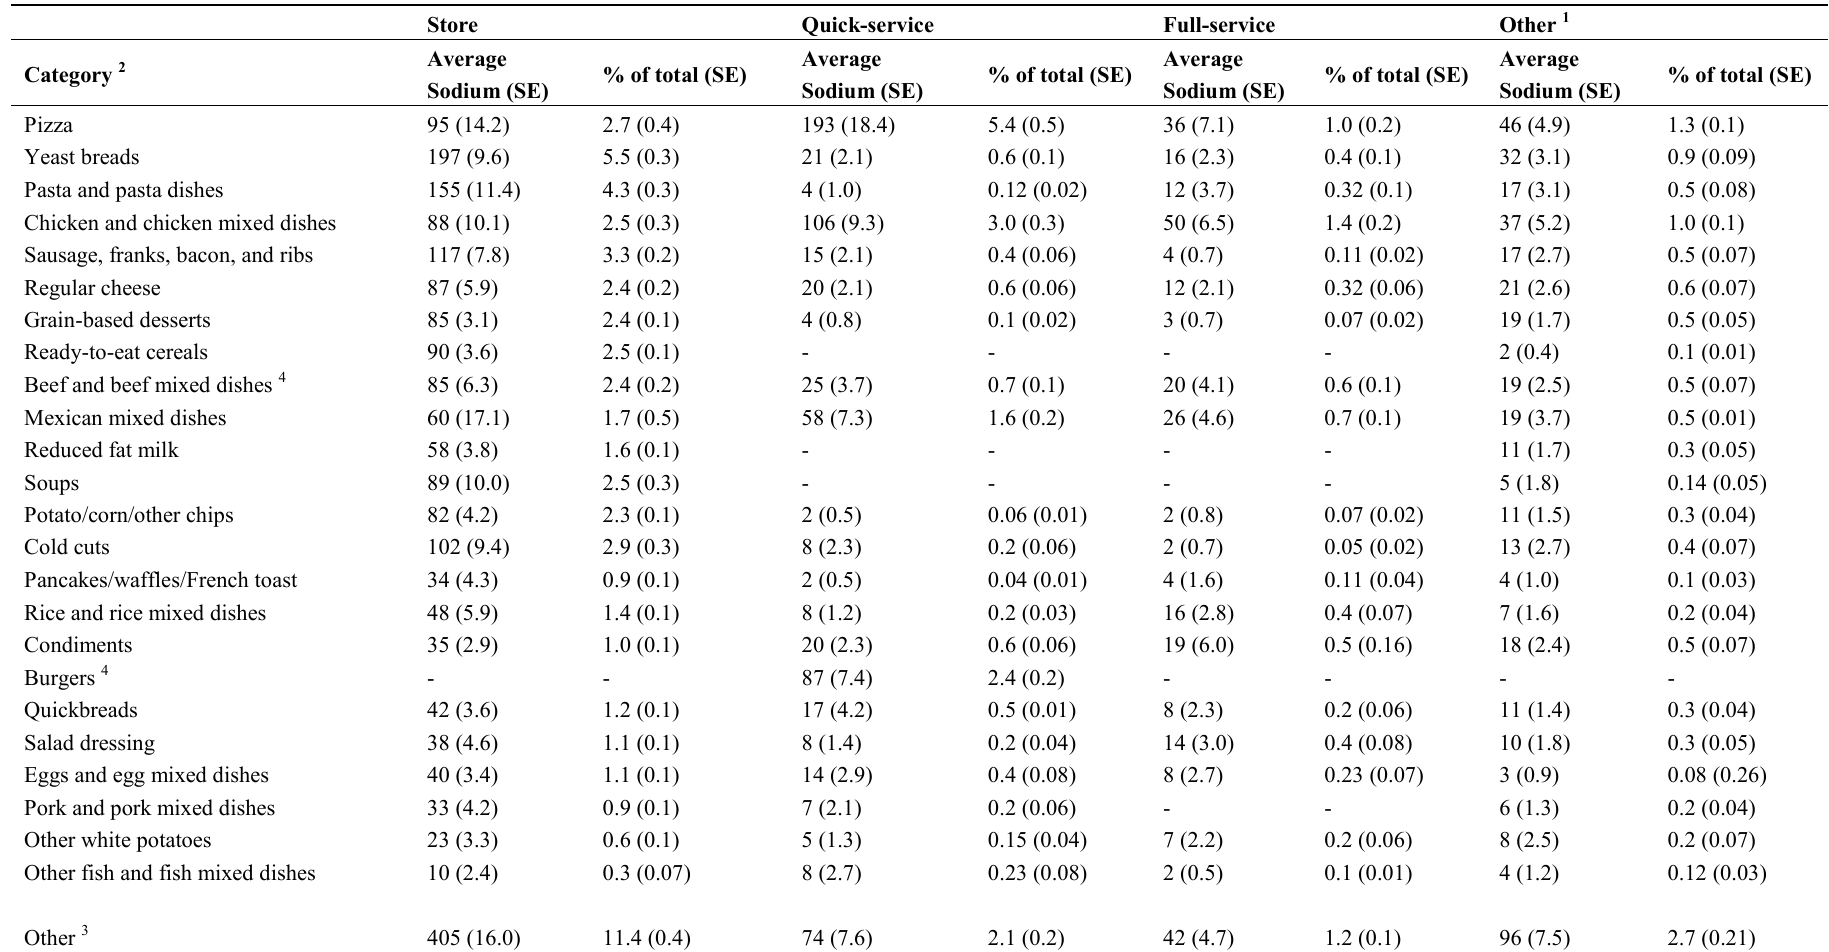
Table 3. Contribution to total sodium intakes from specific food sources by eating location for adolescents (12–19 years), NHANES